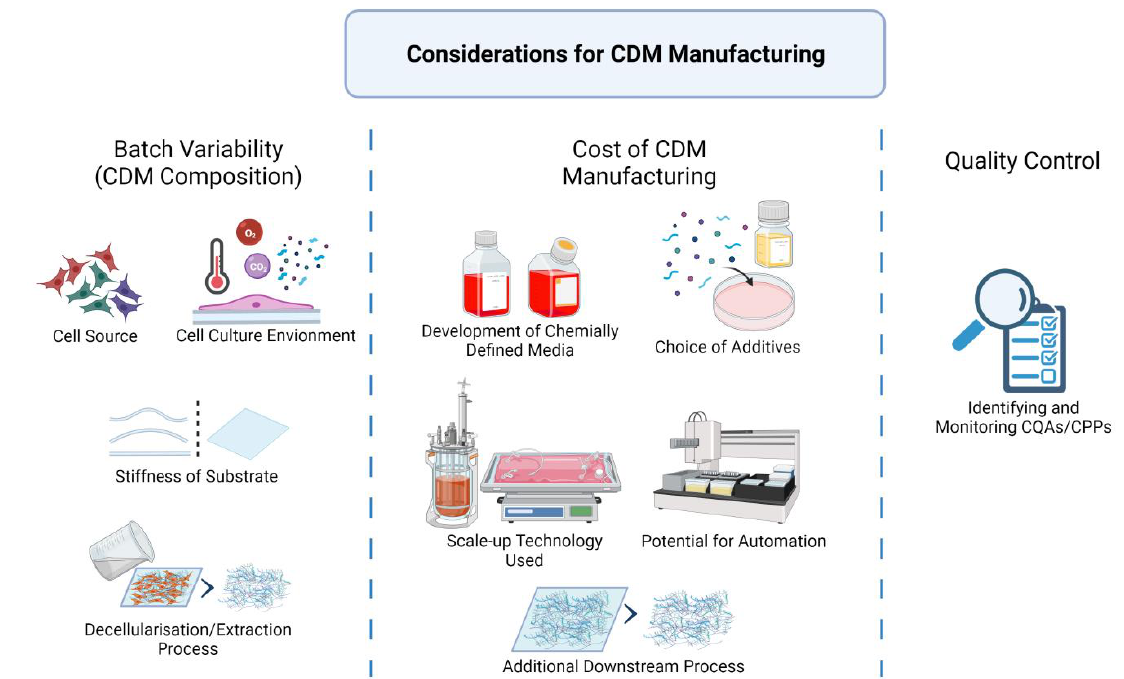
Figure 3. Considerations when scaling up CDM manufacturing. Created with BioRender.com on 1 October 2021.